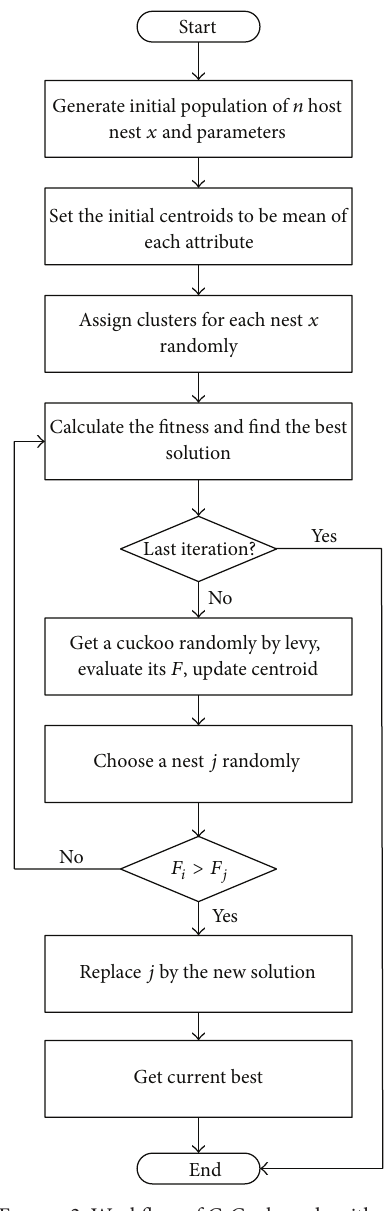
Figure 2: Workflow of C-Cuckoo